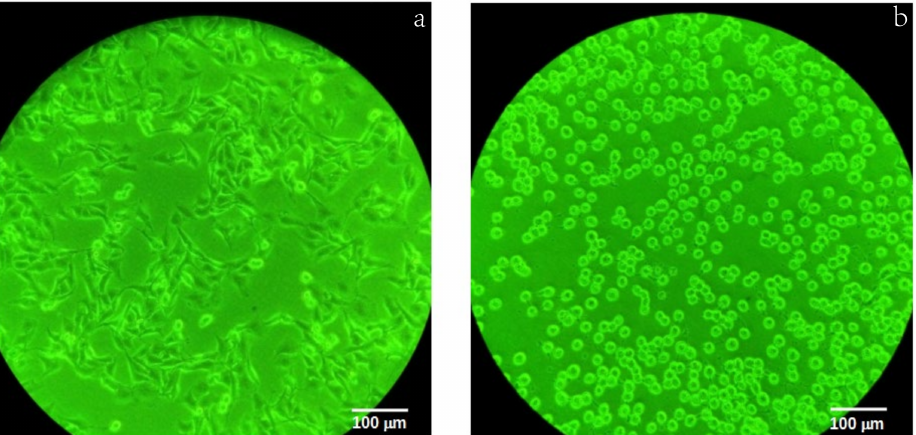
Figure 3. Change in the morphology of MDA-MB-231 cells at ( a ) 0 h and ( b ) after 6 h of incubation after addition of compound 6.